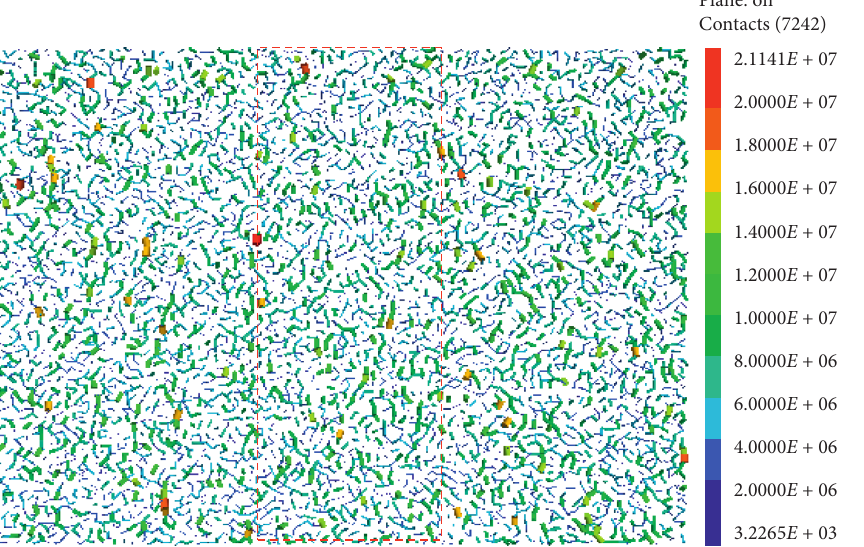
Figure 5: Original distribution pattern of the force chains within the rock masses surrounding the stope.